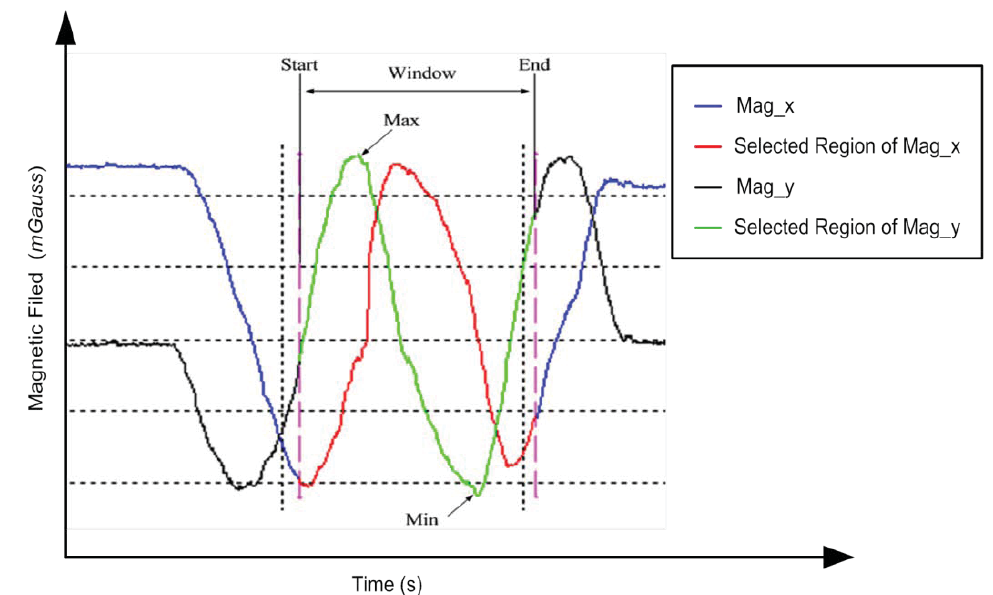
Figure 3. The range of interest selection technique